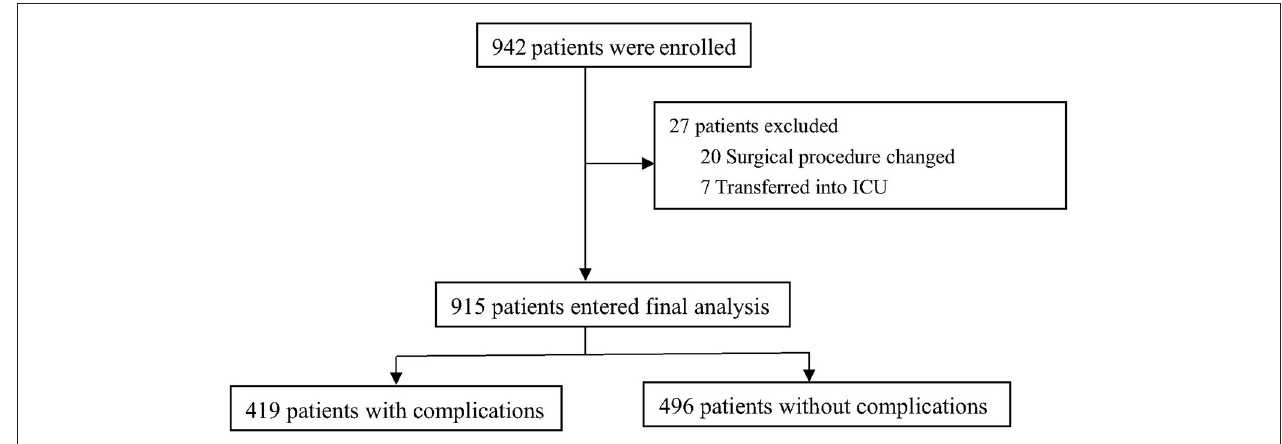
FIGURE 1 | Flowchart of the study. 10 representing severe pain) at the same time interval as that of